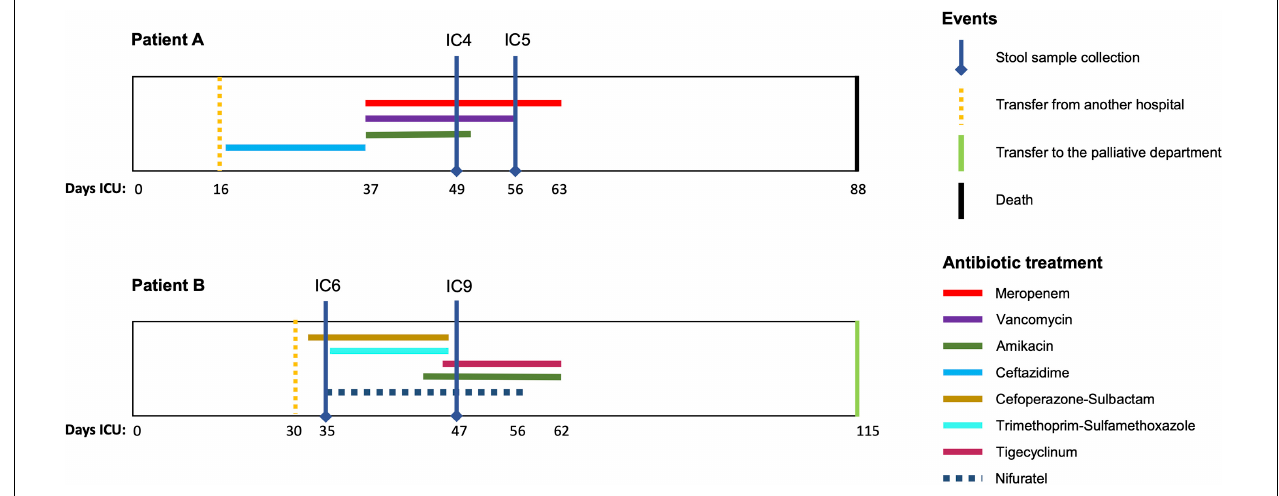
FIGURE 1 | Antimicrobial therapy timelines for the patients. The time courses of the two patients (A,B) included in the study are shown along with the periods (days) of antimicrobial drug administration (colored lines). Vertical lines indicate the key time points for the